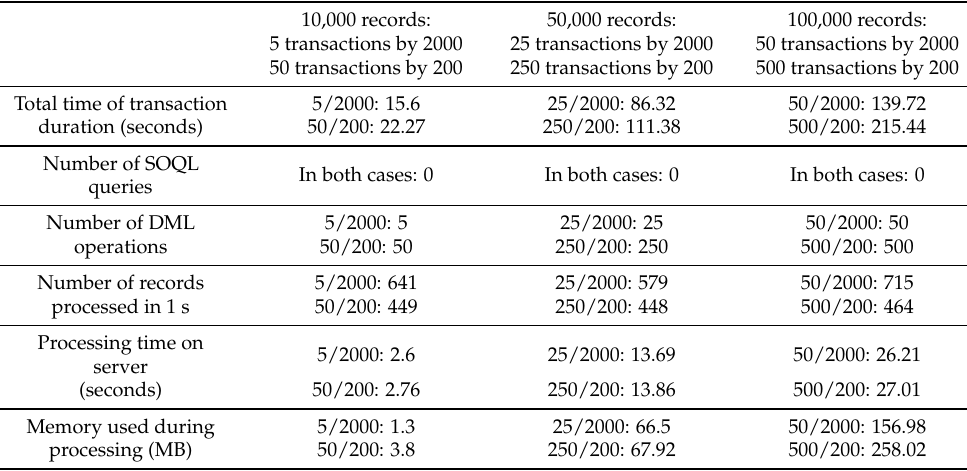
Table 3. Batch Apex processing results for update